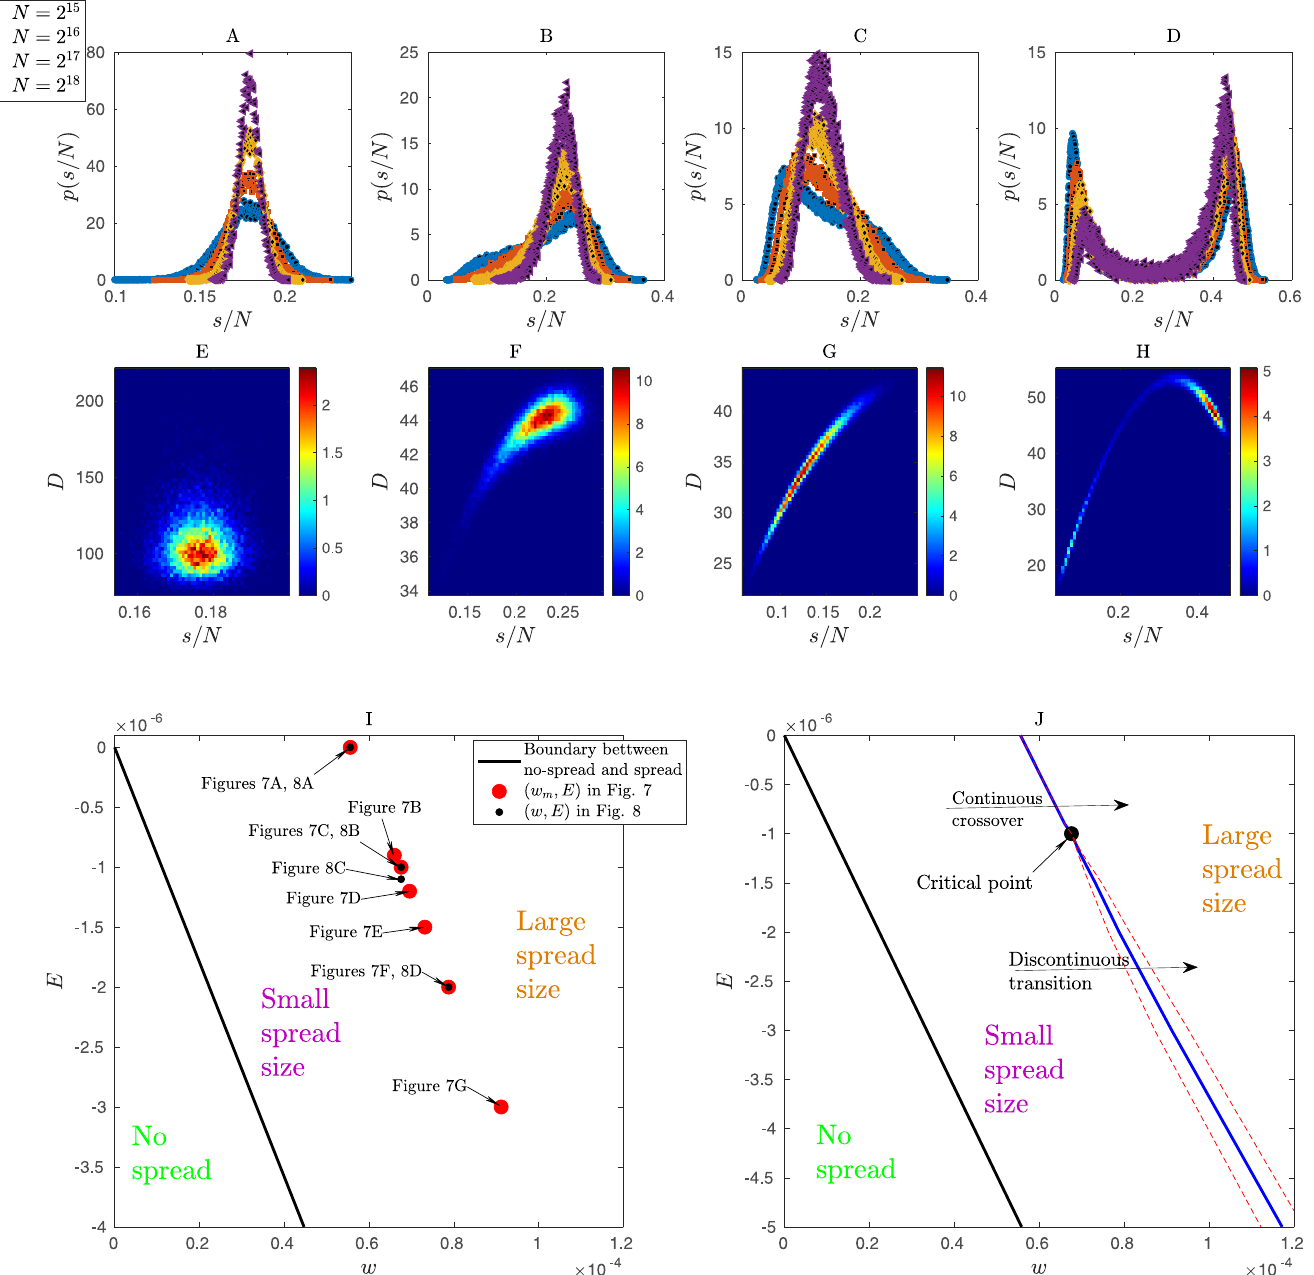
Fig 8. A-D): Marginal Probability density functions of normalized spread sizes s / N . Values are shown for different control parameters ( E , w ) near the critical point. Presented data were obtained from mean-field simulations of the probabilistic model for different system sizes of N = 2 15 , 2 16 , 2 17 , 2 18 . A Unimodal distribution in agreement with a Gaussian, observed for a point at the upper part (with respect to the critical point location) of the boundary between no-spread and spread phases ( E = 0, w = 5.5 × 10 − 5 ). B,C Closer to the critical point ( E = − 10 − 6 , w = 7.67 × 10 − 5 in (B) and E = − 1.1 × 10 − 6 , w = 7.67 × 10 − 5 in (C)), the distributions become skewed with large variance. E The distributions become bimodal near the lower part of the phase boundary ( E = − 2.00 × 10 − 6 , w = 7.88 × 10 − 5 ). ( E-H ): Joint Probability density functions of normalized spread sizes s / N and duration of seizures D . Values are plotted as heat maps for control parameters ( E , w ) near the critical point. The parameters in panels (E,F,G,H) are respectively the same as in panels (A,B,C,D). Data were obtained from mean-field simulations of the model with system size N = 2 18 . E Unimodal distribution, which is roughly in agreement with a Gaussian probability density function (but slightly skewed in the duration coordinate), is found on the upper part (with respect to the critical point location) of boundary between no-spread and spread phases. Duration and size of seizures appear to be uncorrelated. F,G Near the critical point stronger correlation between spread size and duration of seizures is observed and the distribution exhibits a wider peak and stronger correlation in the two dimensional space of ( D , s / N ) in G. H Moving near the boundary lower to the critical point, the joint distribution becomes bimodal with two distinct modes. The locations of the above unimodal and bimodal regimes in the control parameter space ( w , E ) are shown in the next panel with more detail. ( I-J ): Details of the phase